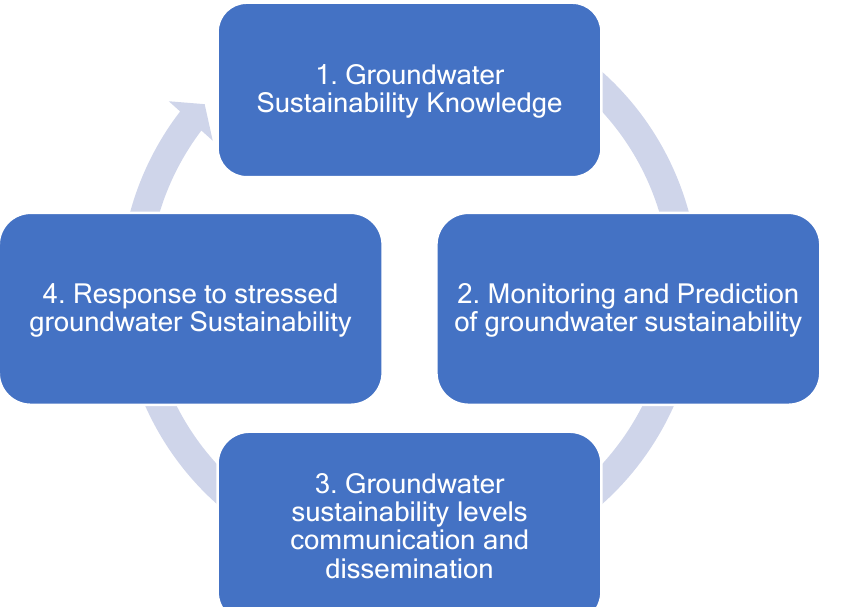
Figure 3. Groundwater Sustainability Early Warning System.